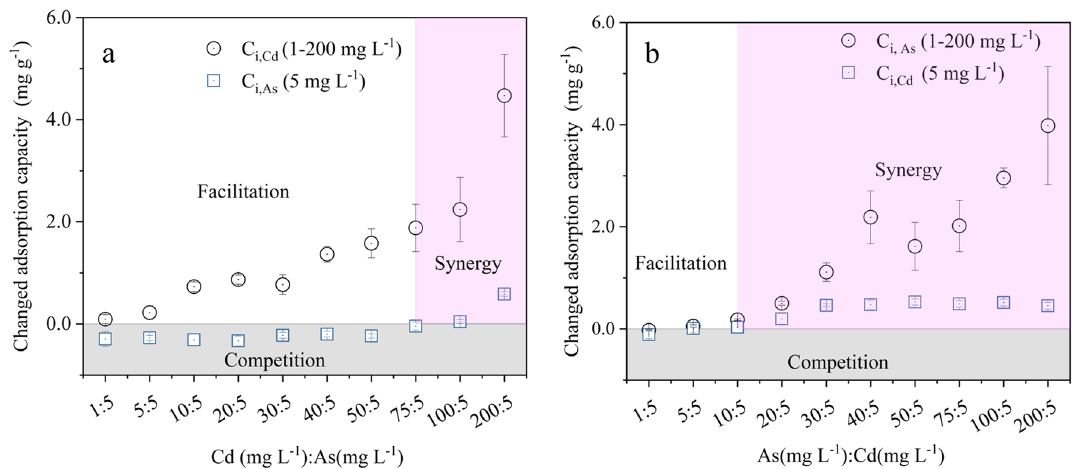
Figure 3. Mutual effect of Cd(II) (C i of 1–200 mg L −1 ) and As(III) (C i of 1–200 mg L −1 ) on adsorption capacities in “Cd + As” system ( a ) and “As + Cd” system ( b ) with sequential